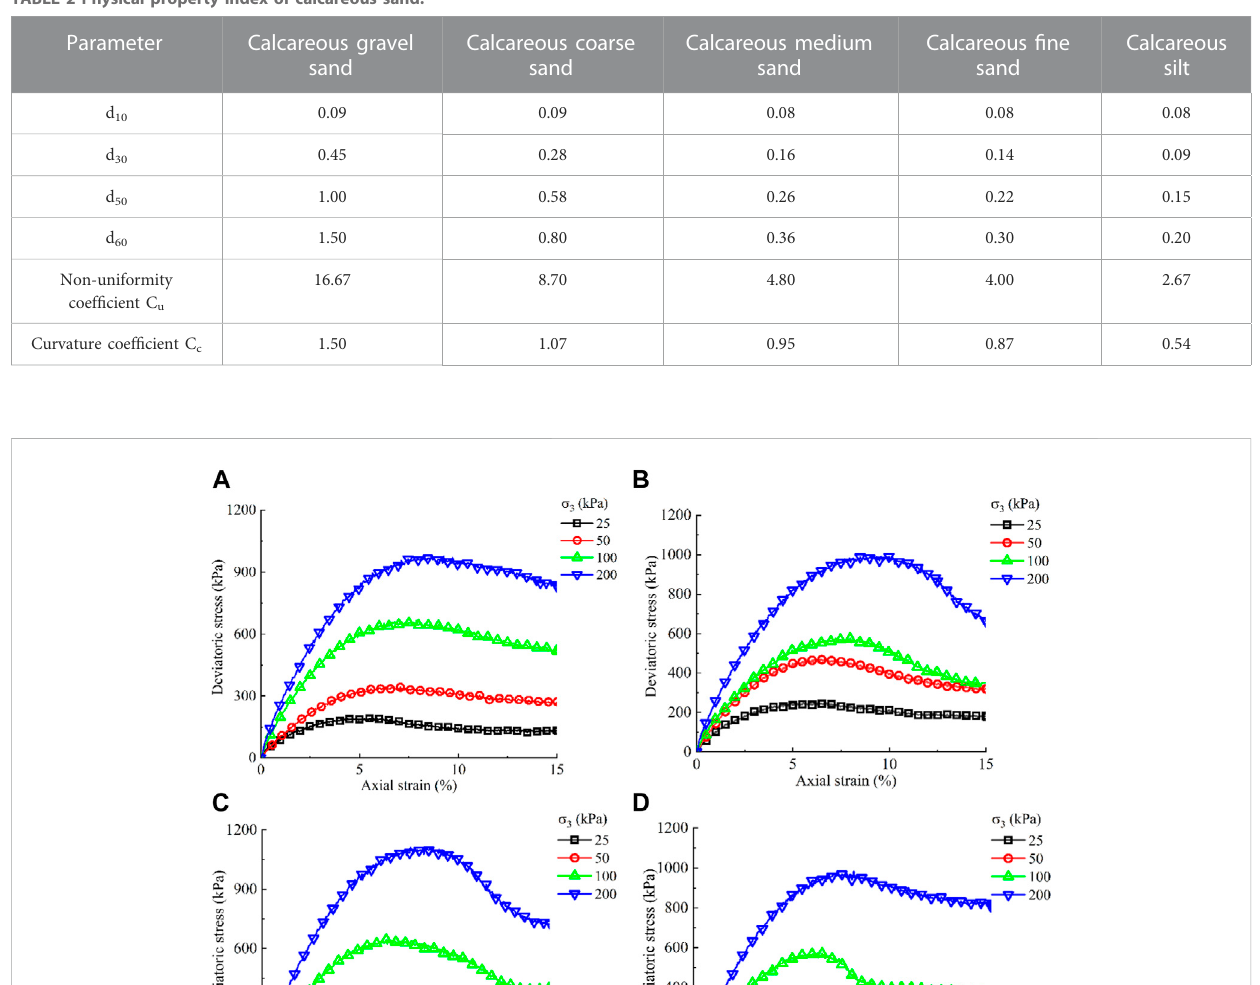
TABLE 2 Physical property index of calcareous sand.